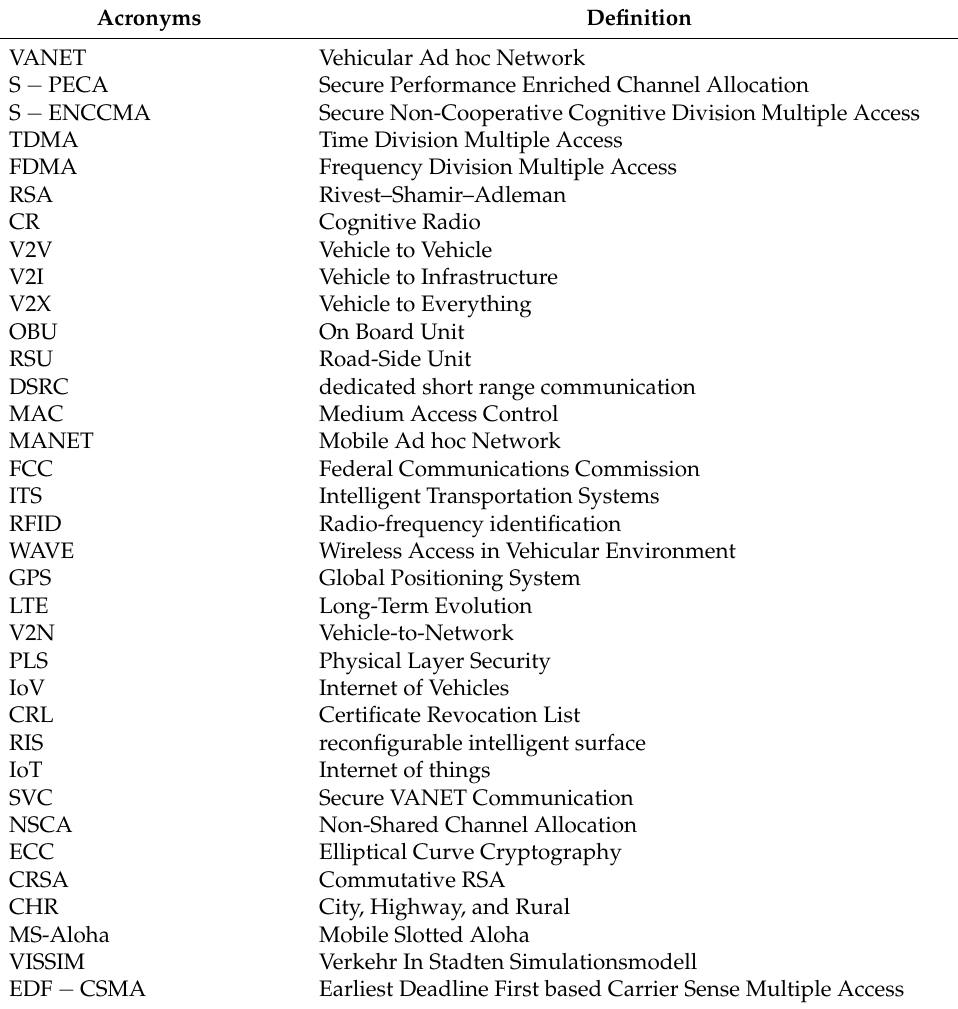
Table 6. Abbreviations and